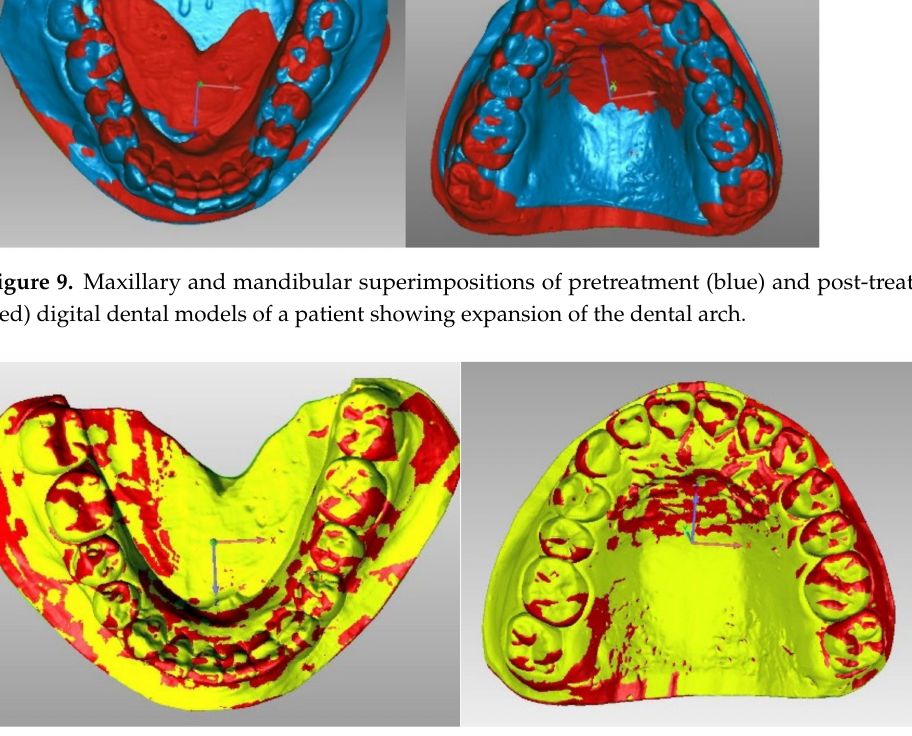
Figure 10. Maxillary and mandibular superimpositions of post-treatment (red) and postretention (yellow) digital dental models of a patient showing stable